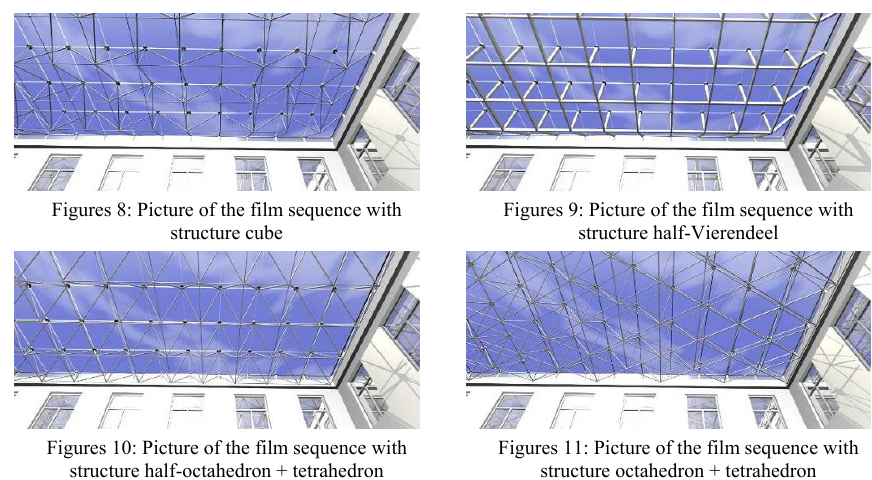
Figures 10: Picture of the film sequence with structure half-octahedron + tetrahedron